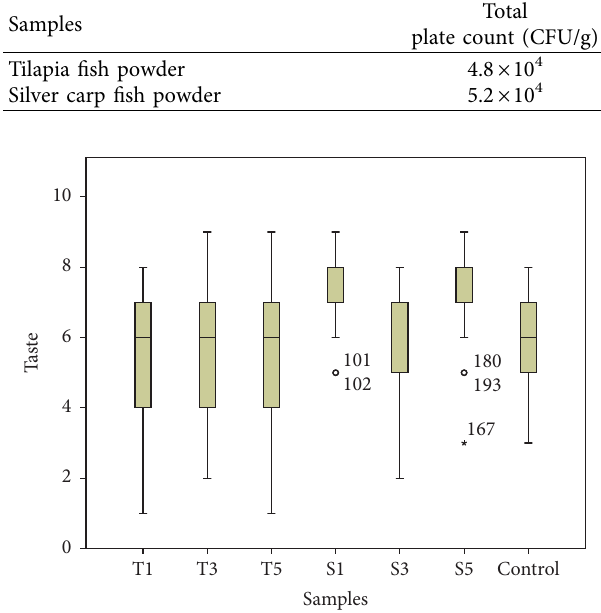
Figure 4: Box-plots obtained for the taste of prepared cake samples.